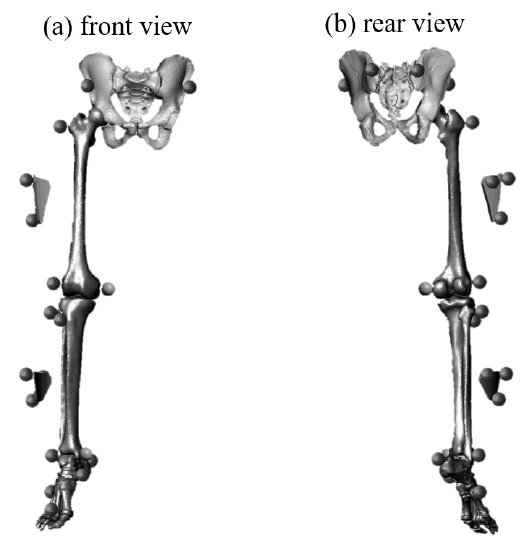
Figure 2. ( a ) Frontal view and ( b ) rear view of reflective marker